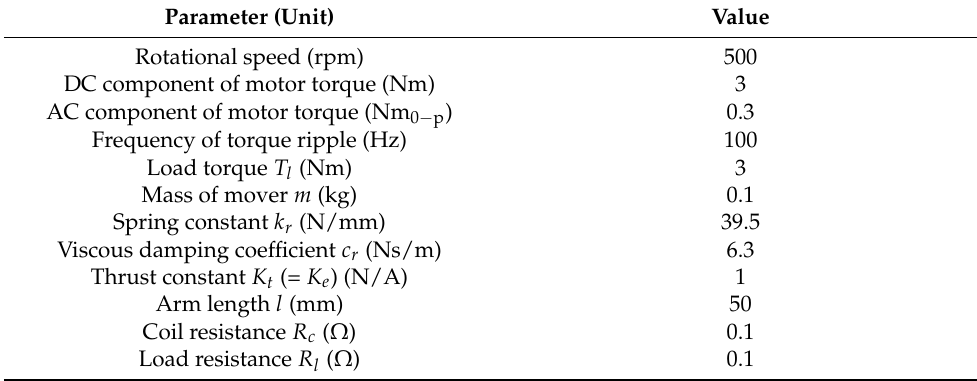
Table 2. Simulation